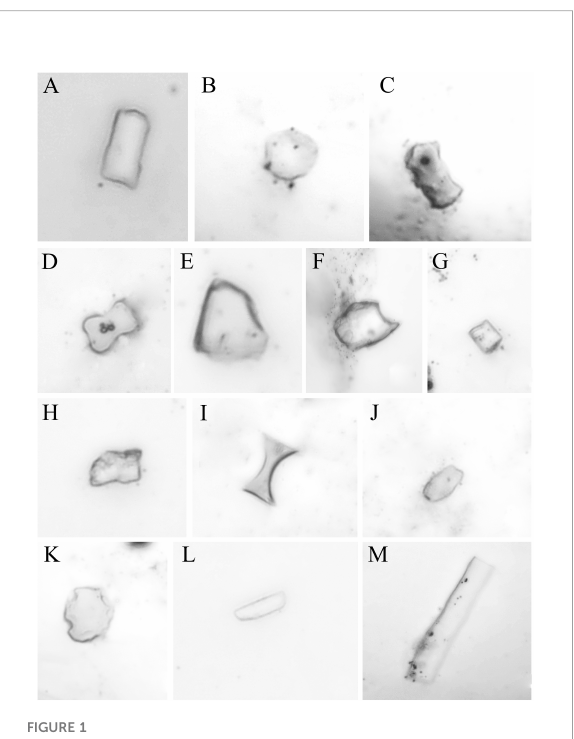
FIGURE 1 Fagopyrum plant phytolith shapes of (A) rectangle, (B) rotundity, (C) bar shape with humps, (D) dumbbell shape, (E) fan shape, (F) ball sharp with tips, (G) square, (H) polygon, (I) saddle sharp, (J) oval, (K) spin ball shape, (L) short bar shape, and (M) bar